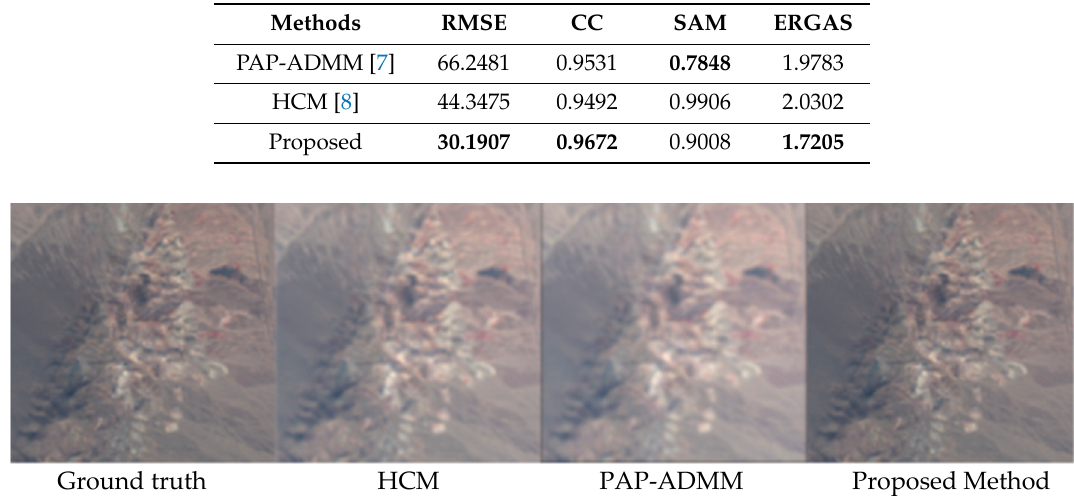
Figure 4. AVIRIS images in visible range using different methods.